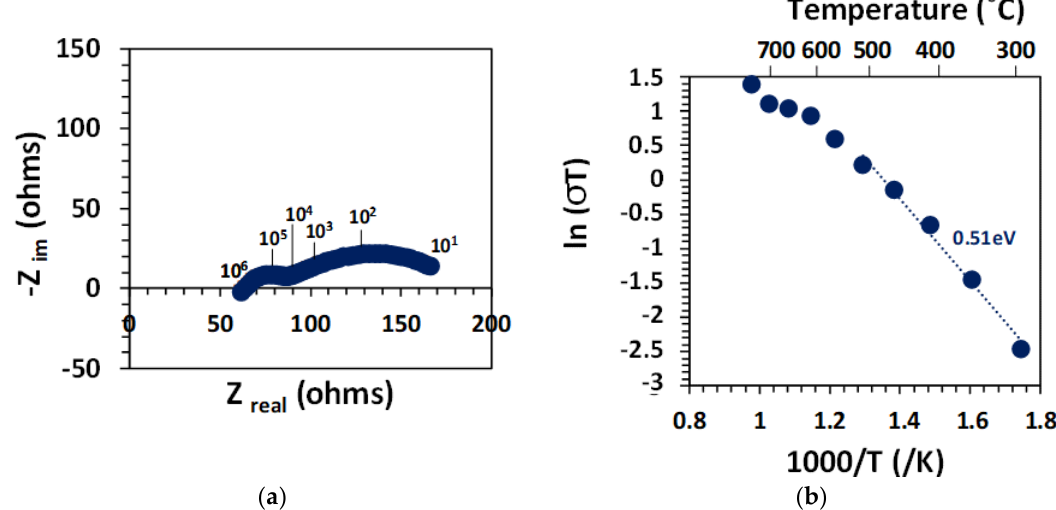
Figure 6. ( a ) Nyquist plot of the spectrum at 550 °C. ( b ) Bulk conductivity on a BZCY755 specimen, with Pt electrodes in 3% moist 10% H 2 balanced argon.